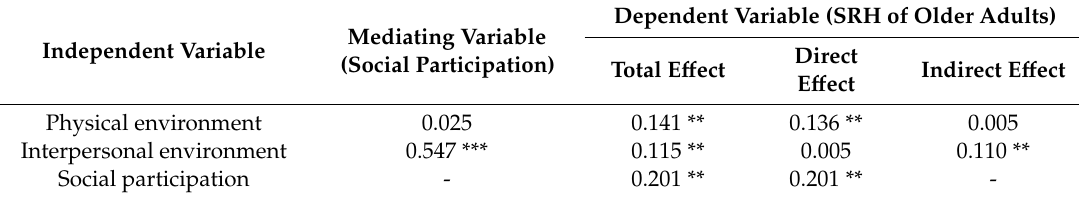
Table 3. Total, direct, and indirect e ff ects of the full sample model.